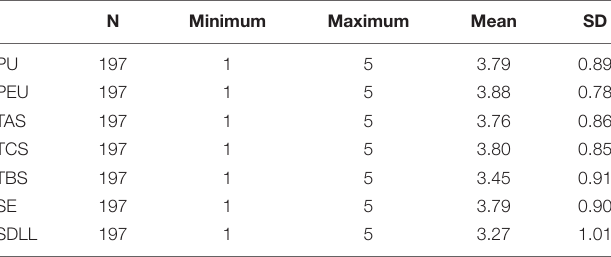
TABLE 1 | Descriptive statistics of study